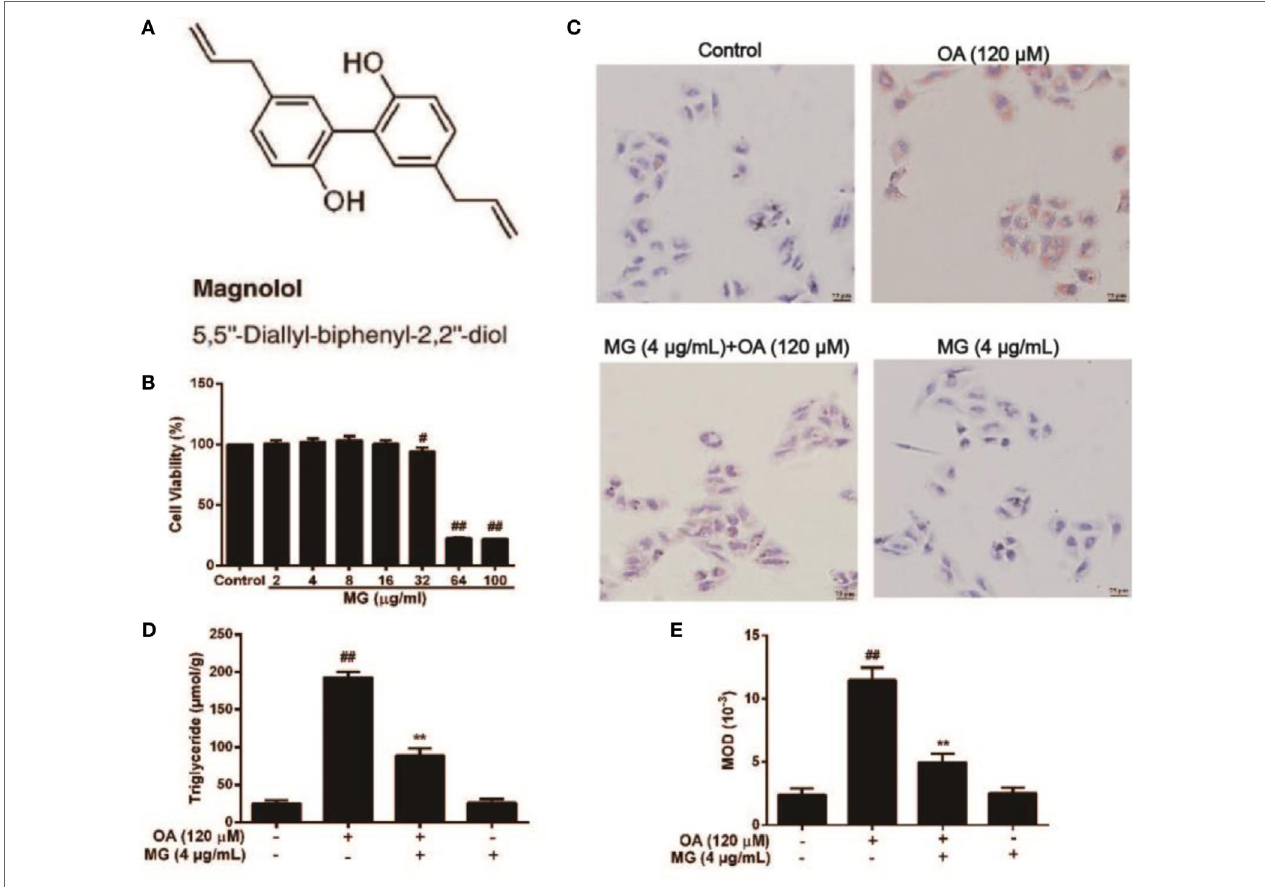
FigUre 2 | Effect of magnolol (MG) on oleic acid (OA)-induced triglyceride (TG) accumulation in HepG2 cells. (a) The chemical structure of MG. (B) Cytotoxicity of MG in HepG2 cells. HepG2 cells were treated with increasing concentrations of MG (2, 4, 8, 16, 32, 64, and 100 µg/mL) for 24 h, and then cell viability was measured by MTT assay. (c,e) Oil Red O staining. HepG2 cells were incubated with MG (4 µg/mL) and OA (120 µM) for 24 h. (D) The inhibitory effect of MG on OA-induced TG accumulation. All data are expressed as the mean ± SD of three independent experiments. Statistically significant at # p < 0.05 and ## p < 0.01 vs. the control group and ** p < 0.01 vs. the OA-treated group (one-way ANOVA followed by Tukey’s